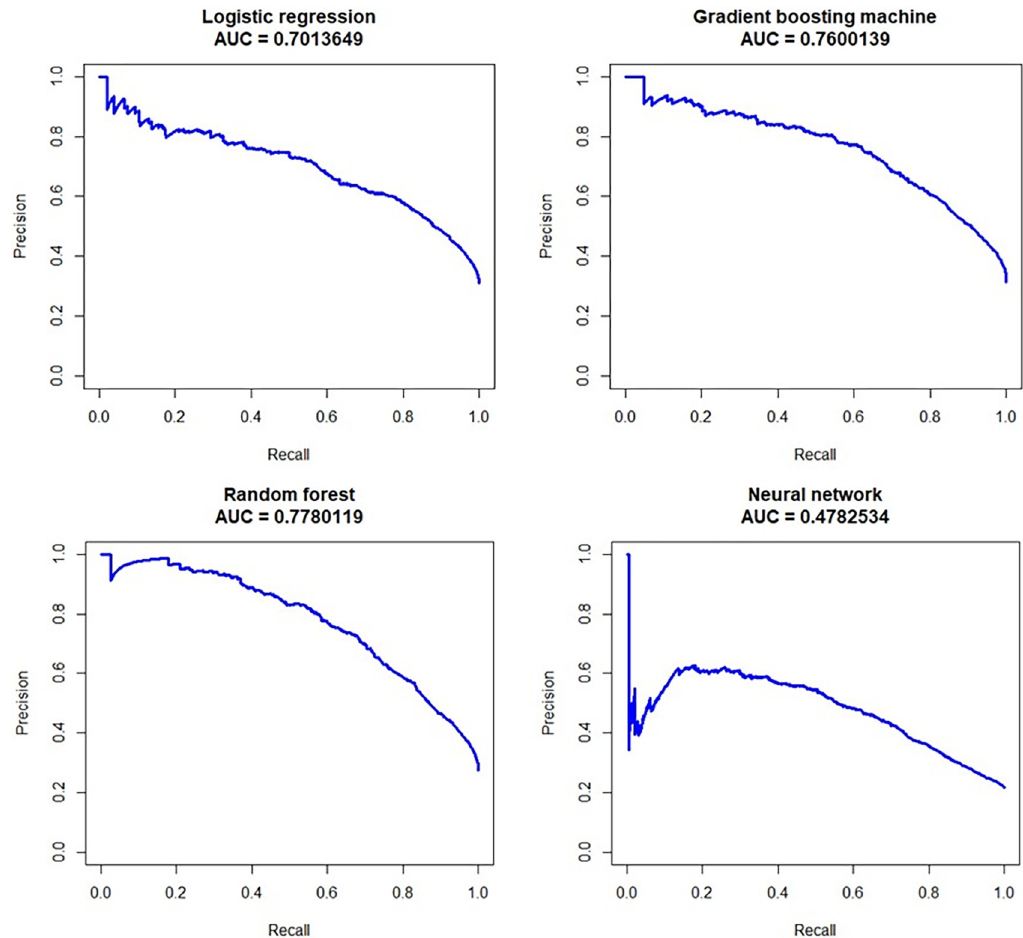
Fig 2. Precision-recall curves of model’s performance on test